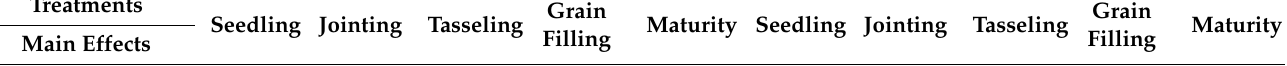
Table 2. Interactive impact of straw mulch and biochar application rates on the stem diameter of the maize